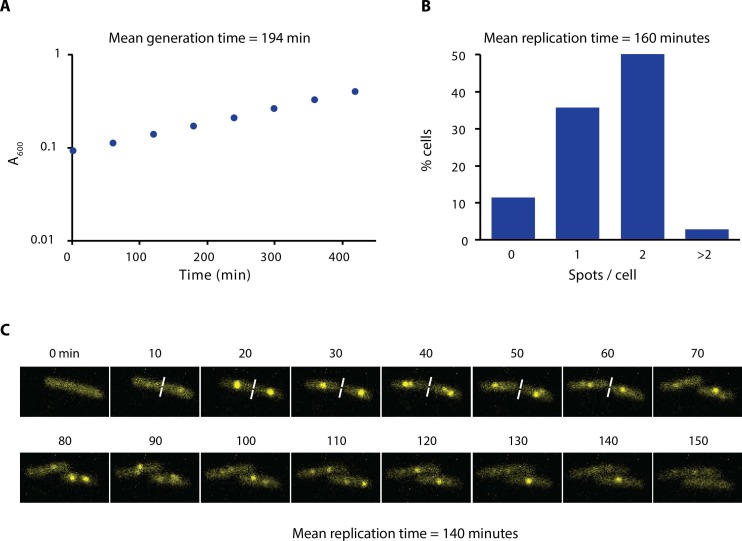
Growth rate and replication time of E. coli in our experimental conditions.(A) Growth curve of AB1157 in M9-Glycerol at 22°C is shown. Samples were taken every hour for 7 hr. (B) Distribution of the number of spots per cell of a strain carrying ε-YPet grown in M9-Glycerol at 22°C (N = 1403 cells). We estimated the replication time by taking into account the generation time and the number of cells with spots. We made the assumption that initiation of DNA replication occurs at cell birth to account for the uneven distribution of cell ages in the population. (C) Representative images obtained from a time-lapse experiment of a strain carrying SSB-YPet grown on a 1% agarose pad in M9-Glycerol at 22°C. Pictures were taken at 10 min intervals. Replication time was determined from the time point of first appearance of SSB-YPet spot to its subsequent disappearance (N = 56 cells). The average of the two methods (150 min) is reported in the main text.